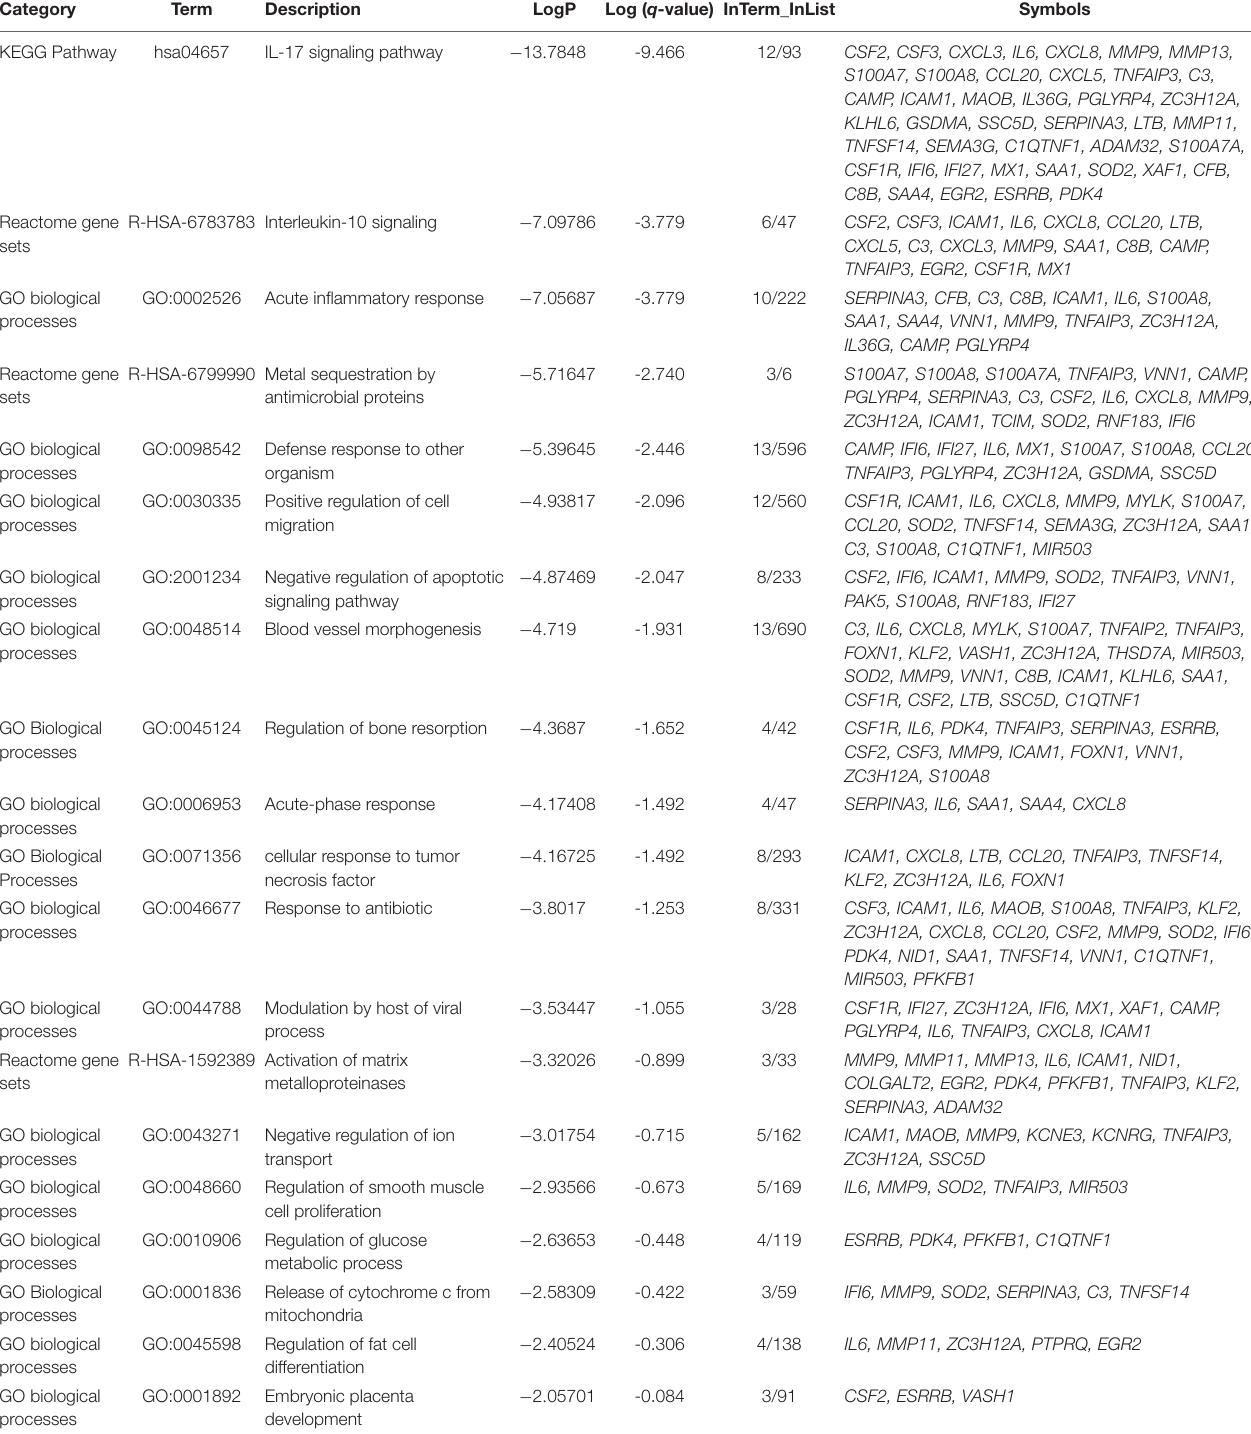
TABLE 3 | Top Gene Ontology (GO) of the top DEGs in infected normal epithelium versus mock-infected cells and the symbols of genes in each pathway. Category Term